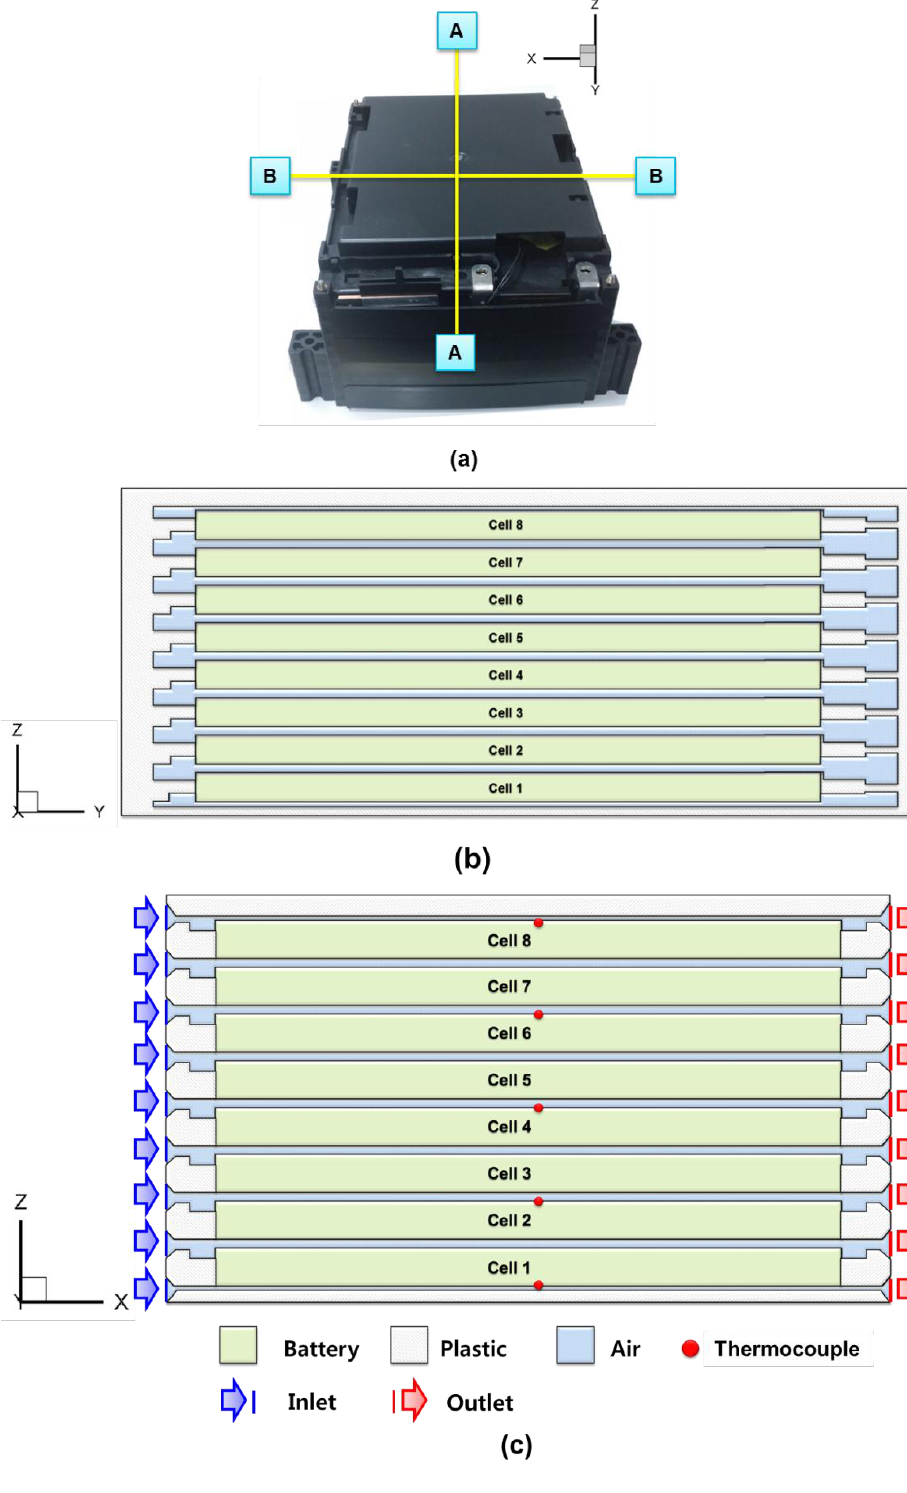
Figure 5. ( a ) Photograph of the LIB module; ( b ) Schematic diagram of the cross section of the module along the line A–A of ( a ); ( c ) Schematic diagram of the cross section along the line B–B of ( a ), the direction of cooling air flow, and the positions for thermocouple measurement; and ( d ) Finite volume mesh used for CFD (computational fluid dynamics) calculations and the direction of cooling air